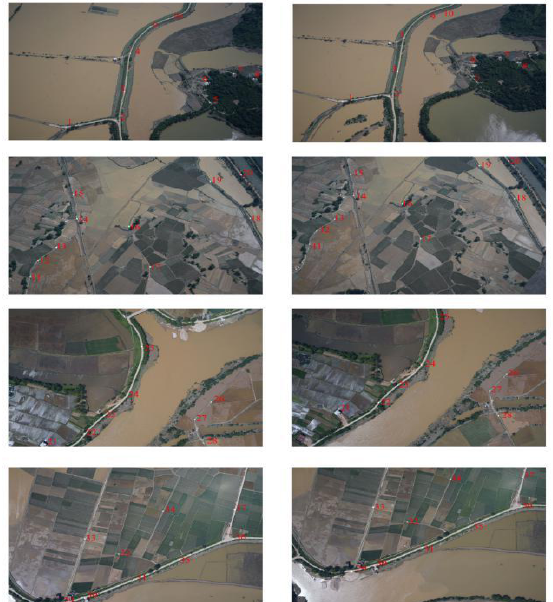
Figure 9. The distribution of the control points